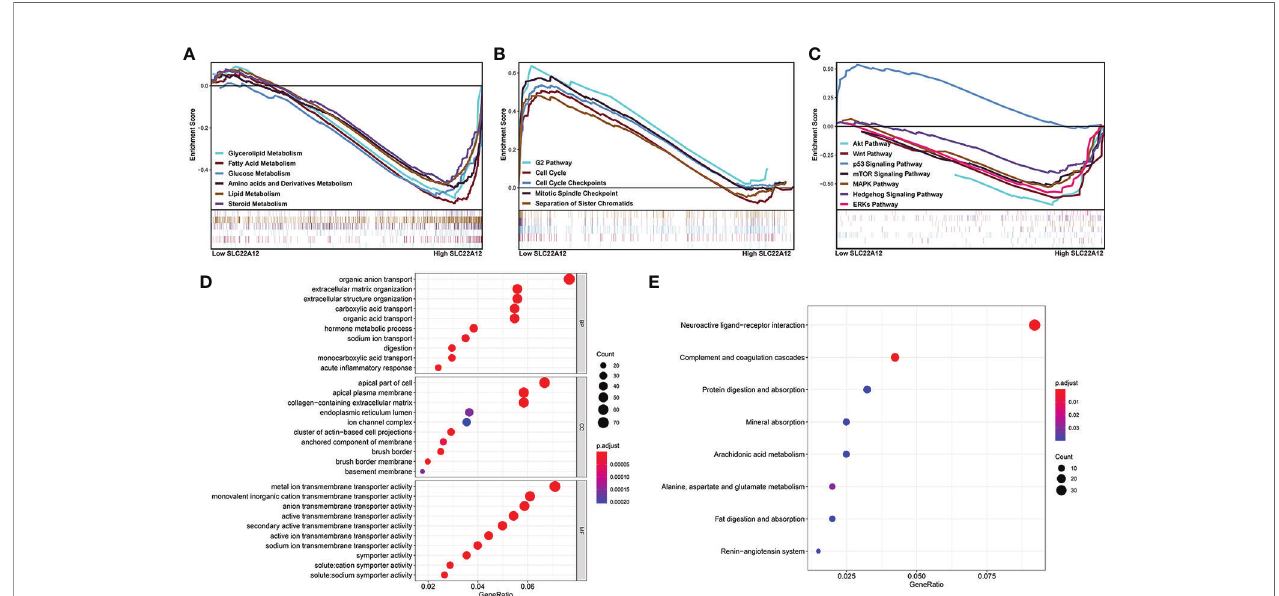
FIGURE 7 | Functional enrichment analysis of SLC22A12 in ccRCC. Gene set enrichment analysis show that the activated genes are related to (A) multiple metabolic pathways, (B) cell cycle, (C) classic cancer-related signaling pathways. The functional differences between high-SLC22A12 and low- groups by (D) Gene Ontology analysis and (E) Kyoto Encylopedia of Genes and